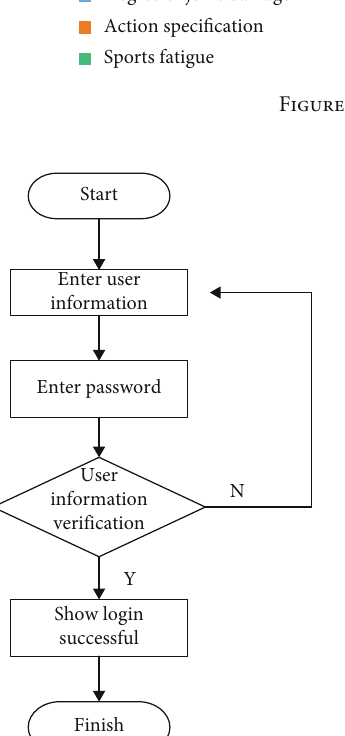
Figure 2: Average score of key parameters.